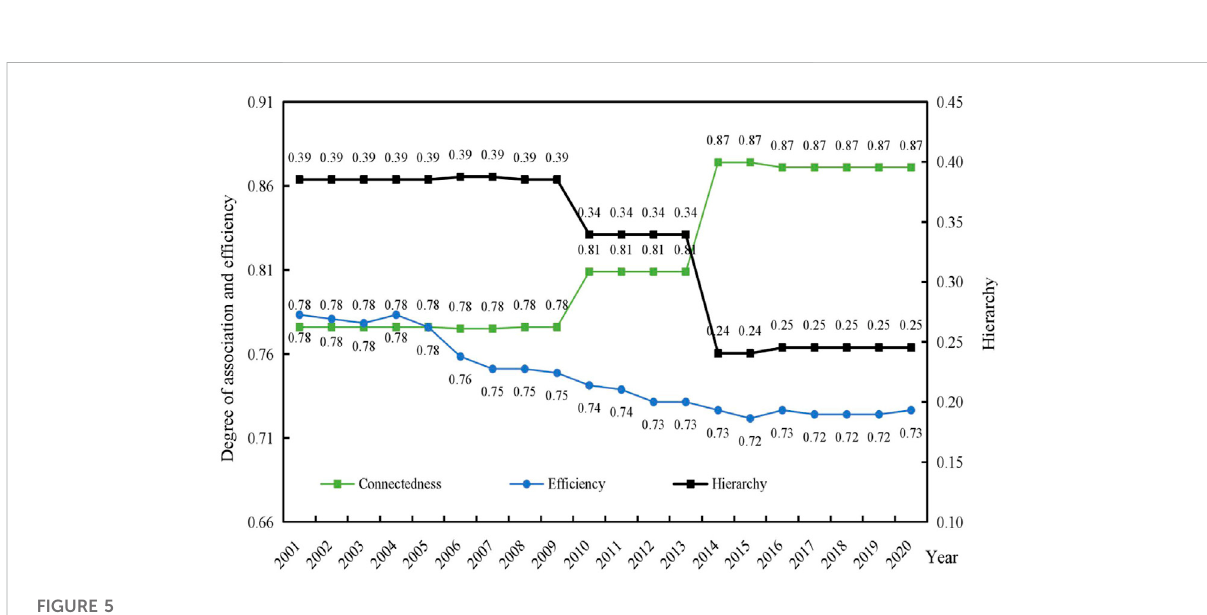
FIGURE 4 Network association and network density.